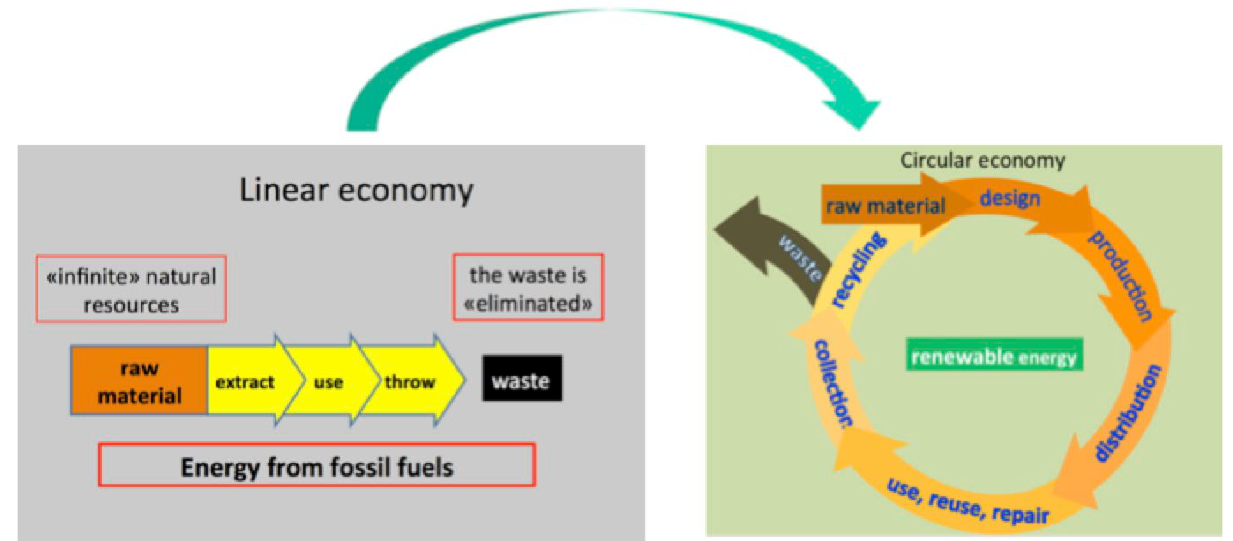
Figure 5. Schematic representation of the transition from a linear to a circular economy (adapted from 16